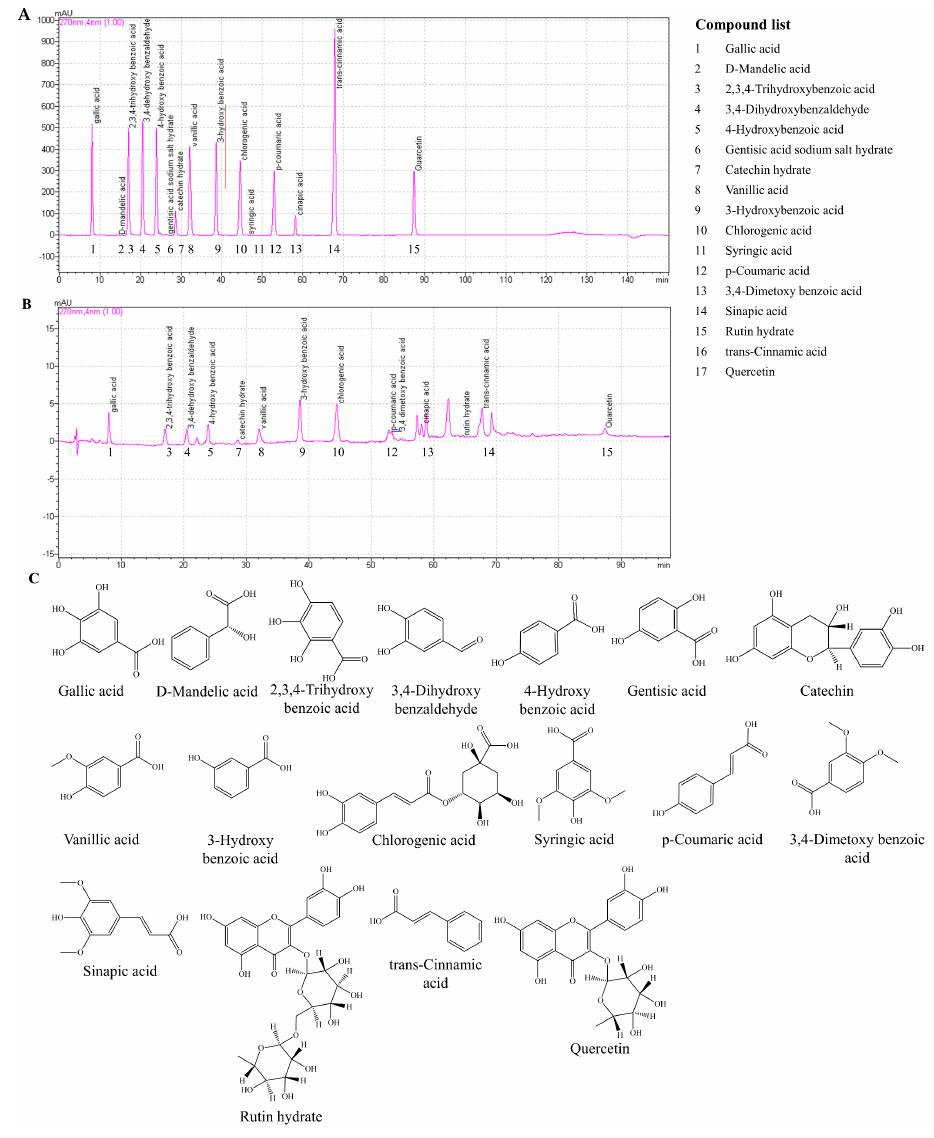
Figure 1. HPLC composition analysis of polyphenols in SBH. Chromatogram of ( A ) flavonoid reference standard and ( B ) SBH. Compounds in SBH were separated using a gradient elution program with a mobile phase consisting of 0.1% formic acid in methanol (solvent A) and 0.1% formic acid in water (solvent B) at a flow rate of 0.34 mL/min; ( C ) Chemical structures of the polyphenols found in SBH.